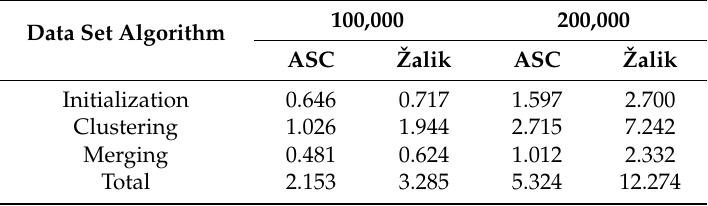
Table 4. CPU time (s) spent by ASC and Žalik for different algorithm